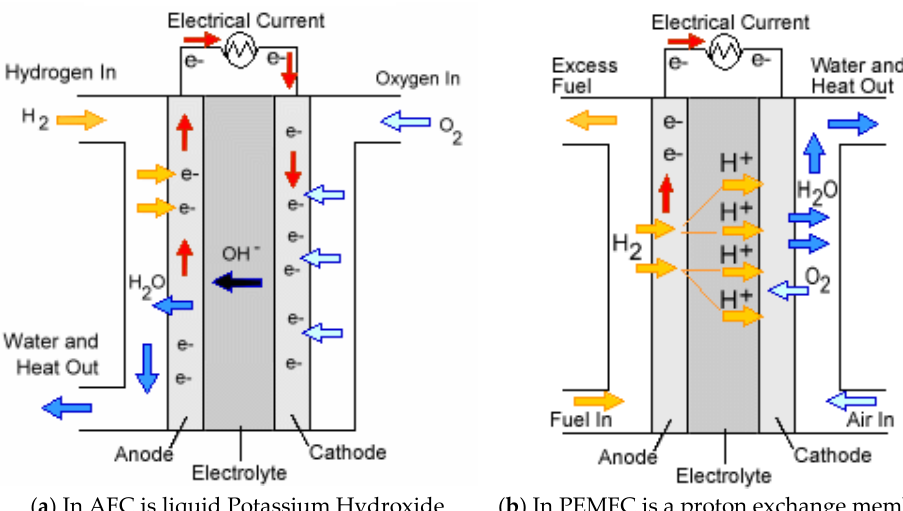
Figure 10. Electrolytes of an Alkaline and a PEM fuel cell [17].